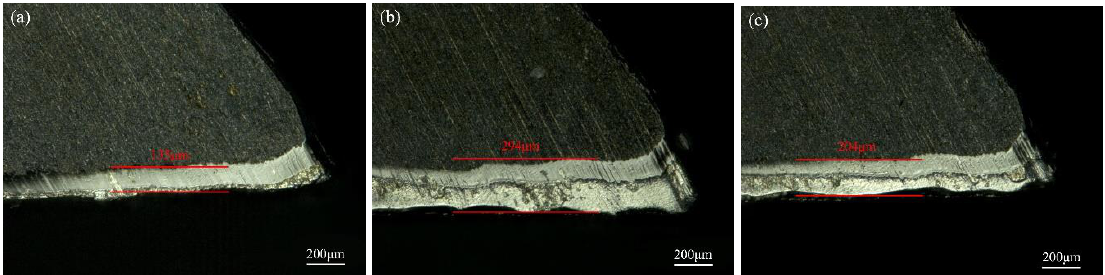
Figure 12. Wear profiles of flank after cutting tests: ( a ) AlCrSiN coated end mill, ( b ) AlCrSiON coated end mill, and ( c ) AlCrSiN/AlCrSiON duplex coated end mill.